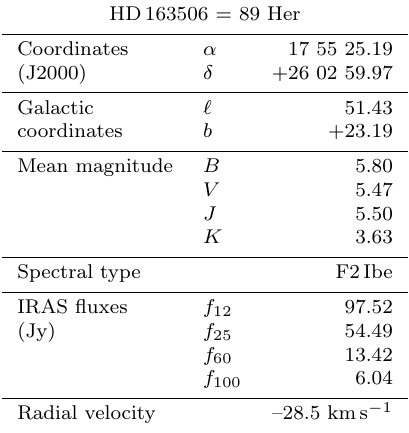
Table 1. Basic parameters of 89 Her (SIMBAD